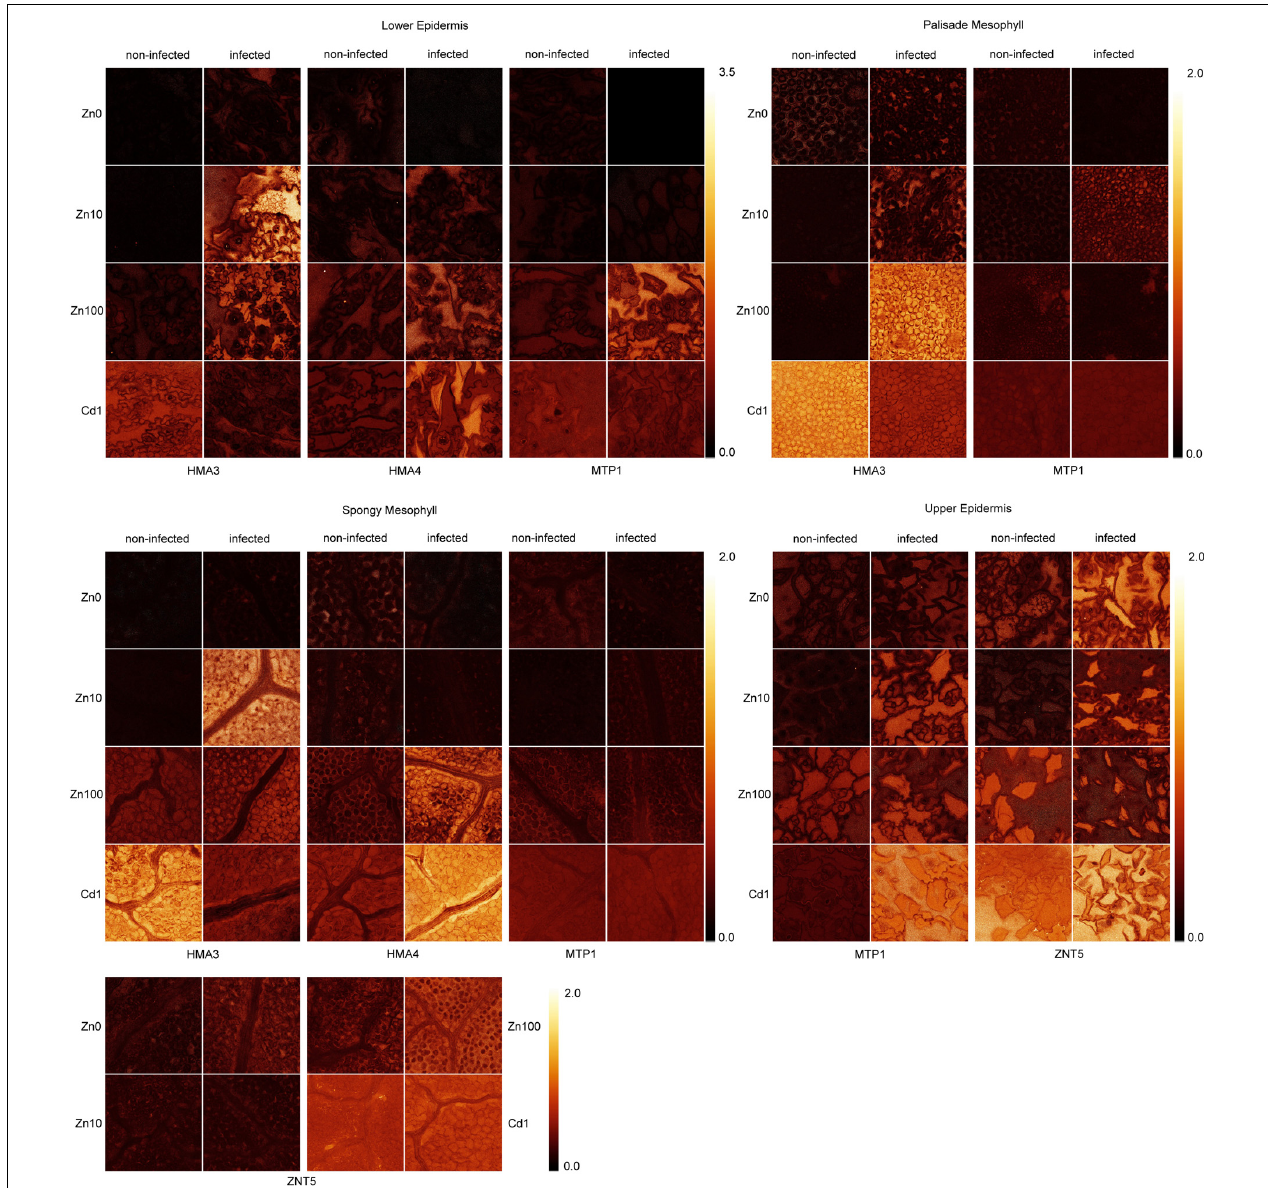
FIGURE 6 | Images showing the gene expression ratio in different tissues of metal transporters to cGADPH probe fluorescent signals of TYMV infected and non-infected N. ochroleucum leaves. Zn0, Zn10, and Zn100 refer to Zn concentrations used in the treatments (‘0’ = 0.01, 10 and 100 µ M Zn), Cd1 refers to a 1 µ M Cd + 10 µ M Zn treatment. The scale bars for all genes within the same tissue are